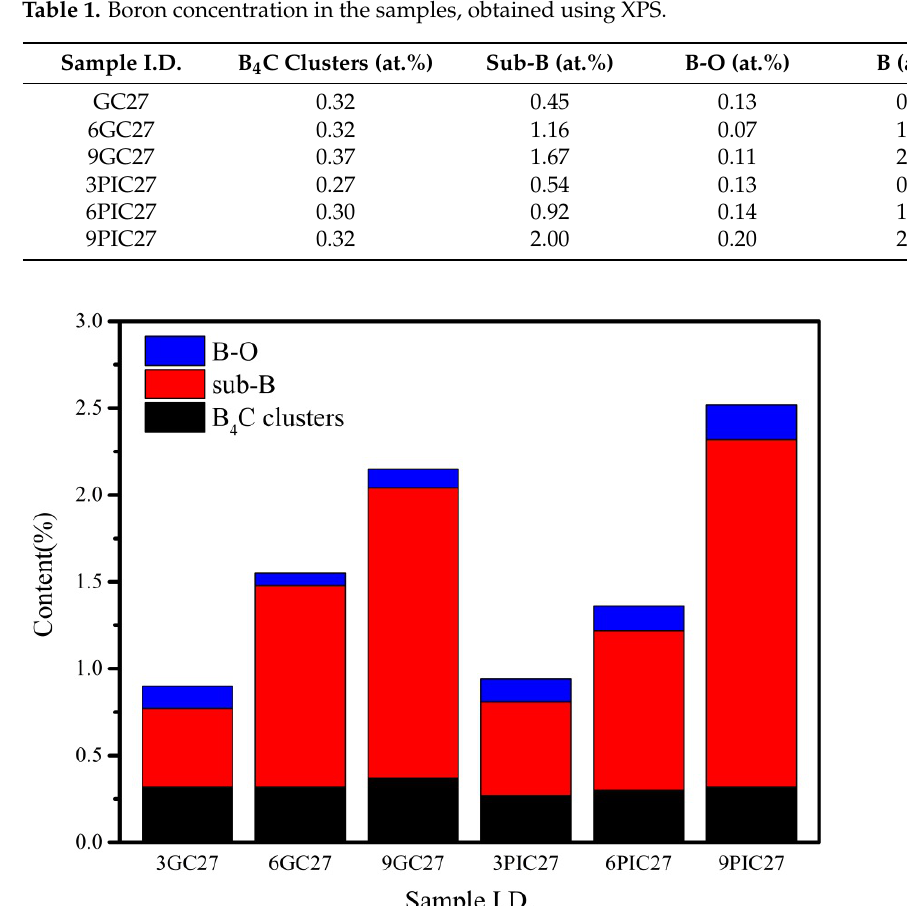
Table 1. Boron concentration in the samples, obtained using XPS.